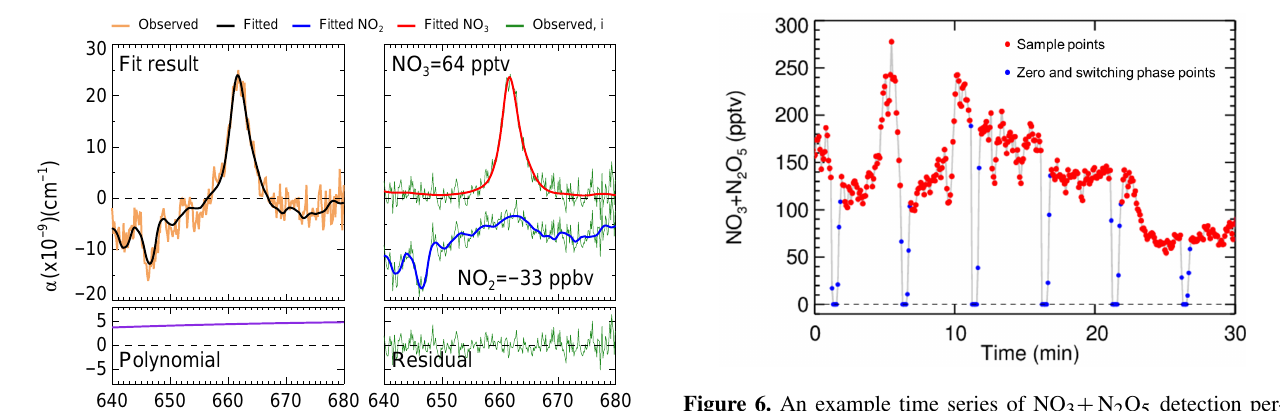
Figure 6. An example time series of NO 3 + N 2 O 5 detection per- formed at a rural site in Beijing with 5s spectrum integral time. The red points denote the ambient measurement mode without NO addition, and the blue points denote the 20s zero points (determina- tion of the dynamic reference spectrum) with NO addition and 20s switching time between the titration mode and the sample